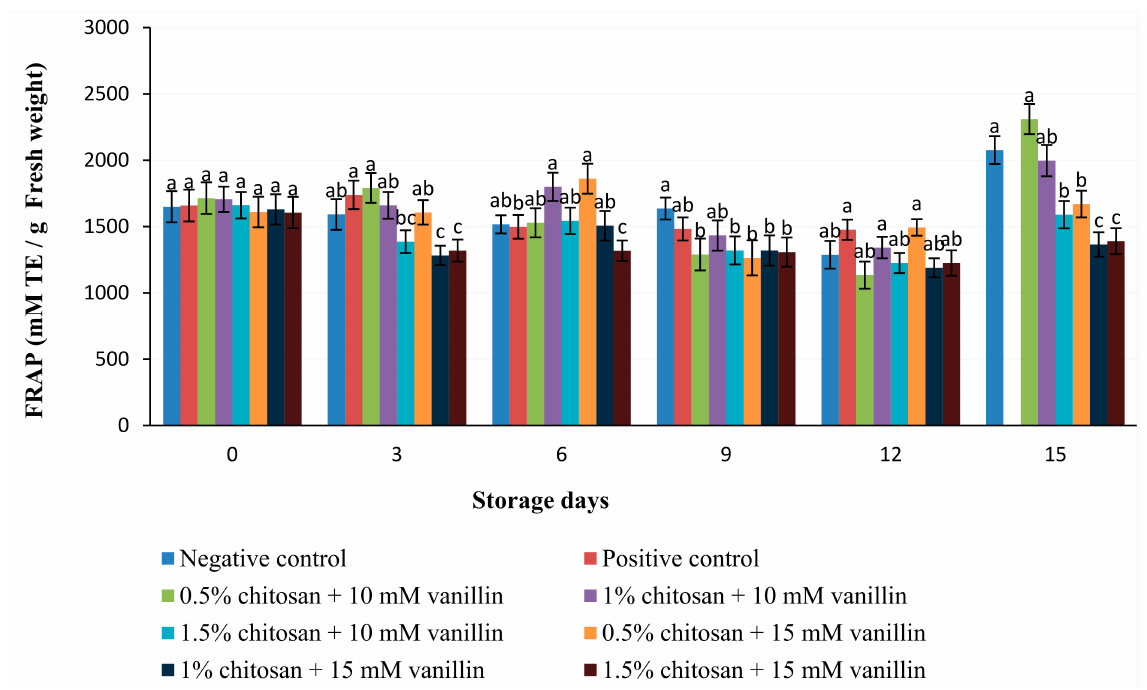
Figure 6. Effects of coating treatment on FRAP in Fusarium oxysporum inoculated tomato fruit stored for 15 days at 26 ± 2 ◦ C and 60 ± 5% relative humidity. Mean values in a column followed by different letters in each storage day differed significantly by LSD at p ≤ 0.05. Vertical bars indicate standard error of means ( n =